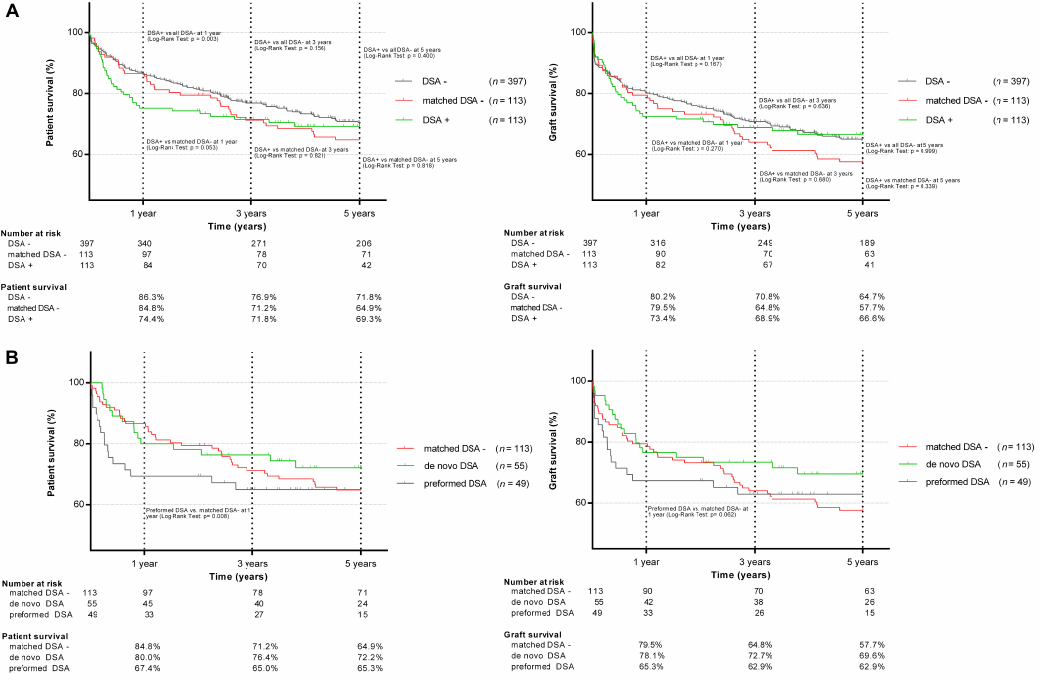
Figure 3. Patient and graft survival in DSA-positive, DSA-negative, matched DSA-negative ( A ), and preformed and de novo DSA ( B ) liver transplant